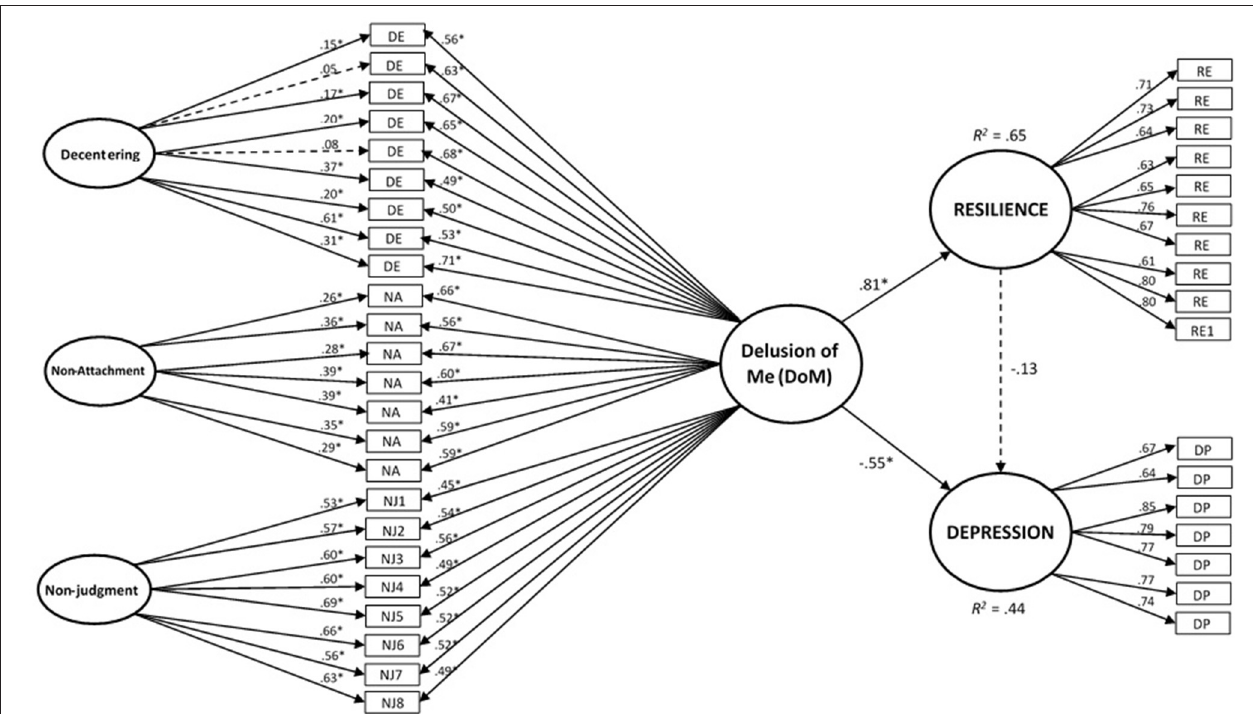
FIGURE 1 | Nomological validity of the “Delusion of Me” (DoM) general factor regarding resilience and depression. Structural equations model of the nomological validity of the “Delusion of Me” (DoM) general factor regarding the constructs of “resilience” and “depression.” The circles represent latent components, and the rectangles are observable variables (items). One-way arrows represent factor loadings (in the measurement model) or standardized slopes (in the structural model). Dashed lines represent non-significant values in the corresponding factor loadings or standardized slopes (i.e., p > 0.05). * p <